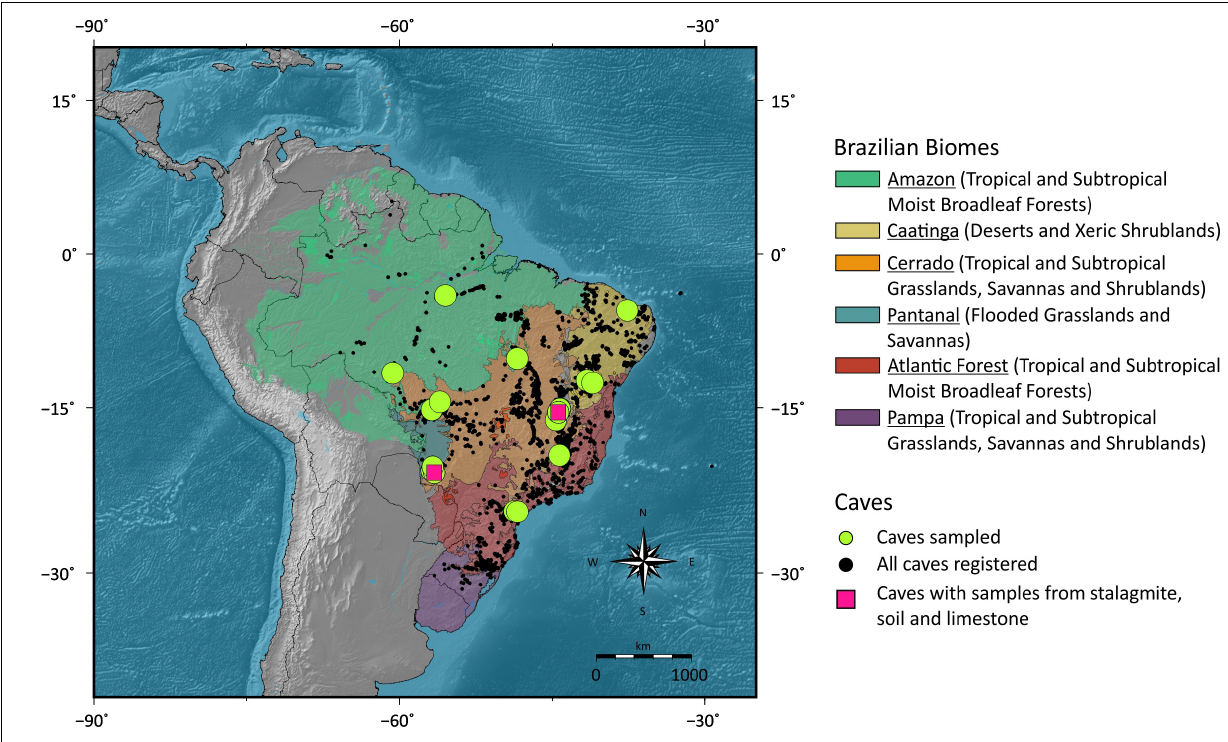
FIGURE 2 | Map of South America, with Brazilian caves (black dots), the speleothems sampled (green circles), and the caves with samples from a stalagmite, soil, and carbonate (pink squares) for rock magnetic characterization in different biomes (Cerrado, Caatinga, Amazon, Atlantic Forest, Pantanal, and Pampa) (Olson et al.,